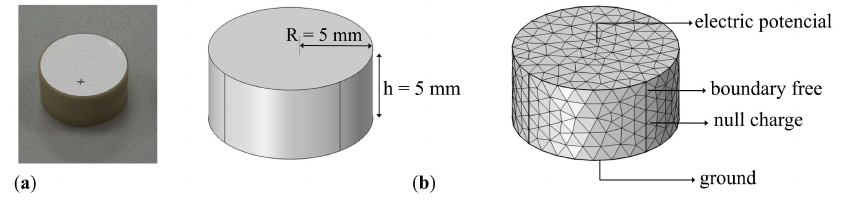
Figure 2. ( a ) PIC 255 ceramic; ( b ) Geometry and 3D finite element meshing of piezoelectric ceramic in COMSOL Multiphysics with radio R = 5mm and thickness h =